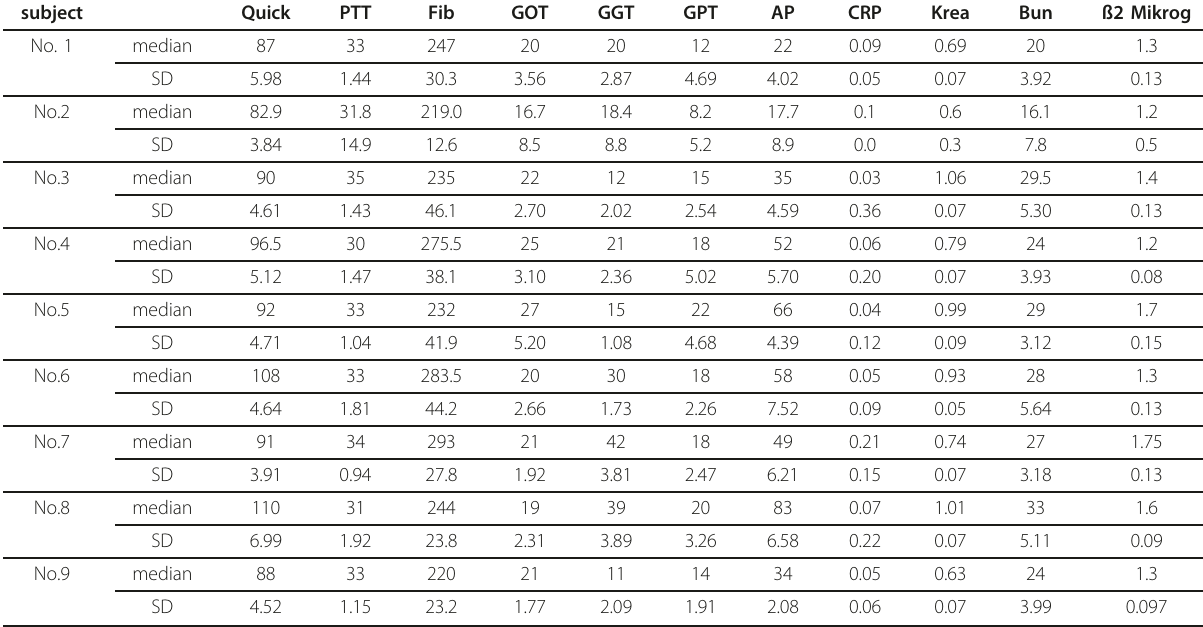
Table 5 Laboratory testing - clinical